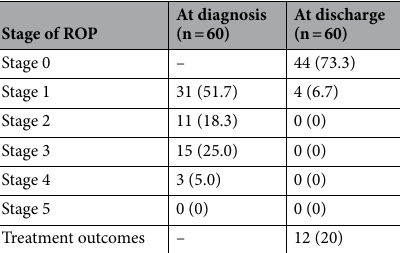
Table 1. ROP stages at diagnosis and discharge of included neonates. Values are presented as count (%).